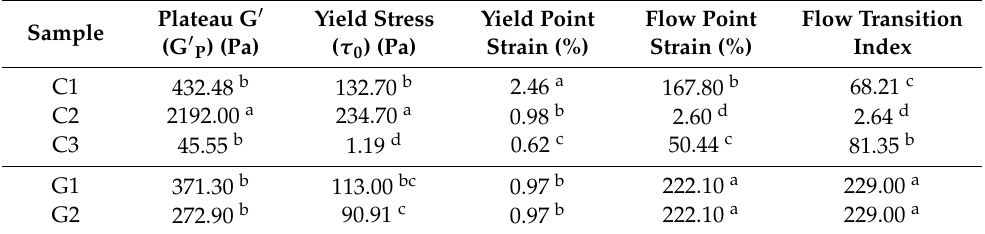
Figure 3. Elastic modulus (G ′ ) and viscous modulus (G ″ ) curves of cream ( a ) and gel ( b ) samples at controlled shear strain. G ′ and loss tangent (tan δ ) curves of cream ( c ) and gel ( d ) samples as a function of shear stress. Horizonal reference lines in ‘plot c’ and ‘plot d’ are placed at 1 tan δ . Table 3. Rheological properties of cream and gel samples derived through controlled shear strain oscillatory sweep.